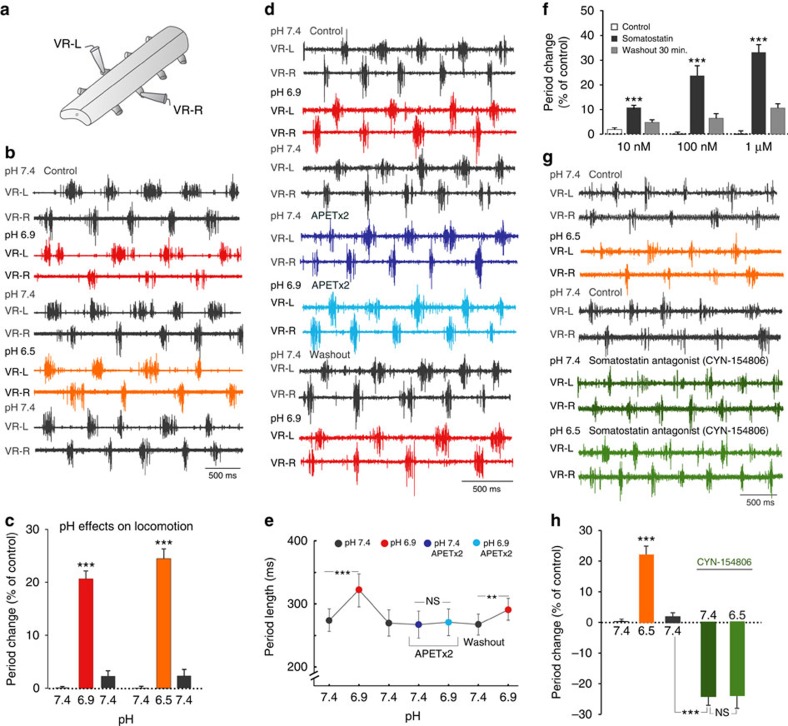
Lowering of extracellular pH or application of somatostatin reduces the locomotor rhythm.(a) Illustration of arrangement for ventral root recordings with suction electrodes in the intact, isolated spinal cord preparation (VR-L, VR-R, left and right side ventral root, respectively). (b) Bilateral ventral root recording during NMDA (100 μM)-induced fictive locomotion in the isolated lamprey spinal cord, during control conditions (pH 7.4; black traces) and during lowered pH of 6.9 (red traces) and 6.5 (orange traces). (c) Decreases in extracellular pH prolonged the cycle period. The mean period was determined during 20 cycles for each of the conditions and normalized to the value during control conditions (% of control; n=7). (d) Bilateral ventral root recording during control conditions (pH 7.4; black traces), during pH 6.9 (red traces) and in the presence of the ASIC3 blocker APETx2 (1 μM; blue traces). (e) Application of APETx2 blocked the effect of lowered extracellular pH (6.9) on the cycle period, which recovered upon washout (mean values calculated for 20 cycles during each condition; n=2 preparations). (f) Effect of somatostatin (10 nM, 100 nM and 1μΜ) on the cycle period of the locomotor activity. Somatostatin significantly increased the period at all tested concentrations (n=19). (g) Bilateral ventral root recording in the isolated spinal cord, during control conditions (pH 7.4; black traces), during pH 6.5 (orange traces) and following application of the somatostatin receptor sst2 antagonist CYN-154806 (2 μM; green traces). (h) Application of CYN-154806 lead to a shortening of the period length at control pH 7.4 (dark green; n=4). In the presence of the antagonist, a decrease of pH (here to 6.5; light green) had no effect on the cycle period. The data are represented as means±s.e.m. (c,f,h) and ±s.d. (e); Student's t-test: ***P<0.001; **P<0.01, significant difference compared with control; NS: non-significant, NSP>0.5.